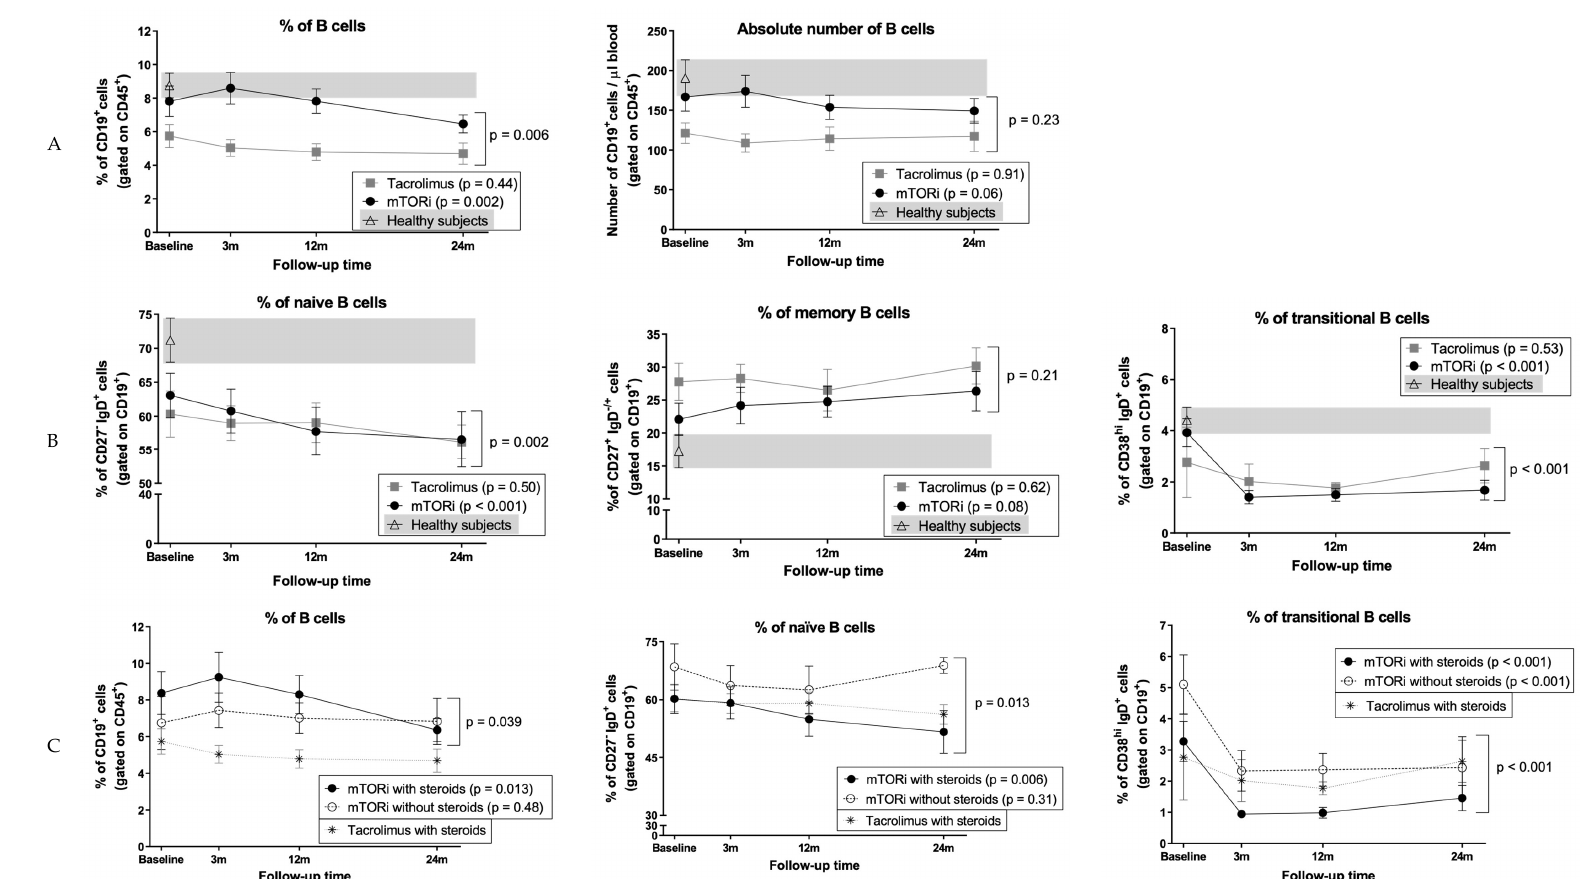
Figure 3. Evolution of B cells after switching from tacrolimus to mTORi. Immunophenotyping of ( A ) total B cells and ( B ) naïve, memory, and transitional B cells in patients before and after switching to mTORi (black dots) and patients maintaining tacrolimus (grey squares). HS data is depicted with white triangles, and the grey background corresponds to range. Plots show mean and SEM for each time point. Immunophenotyping analysis of ( C ) total, naïve, and transitional B cells in patients switching from tacrolimus to mTORi with (black dots) and without (white dots) concomitant steroid treatment. Patients who maintained tacrolimus and steroids are marked with (*) as a